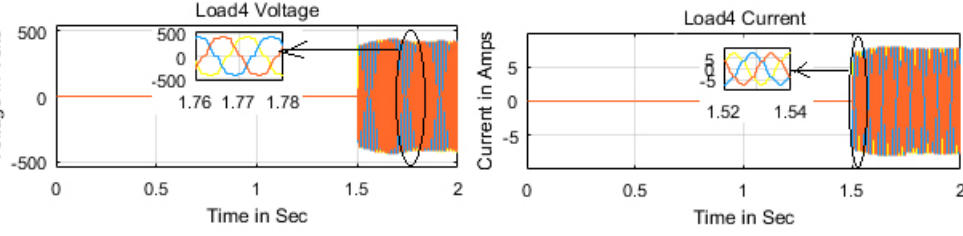
Figure 26. Load4 Voltage & Current.